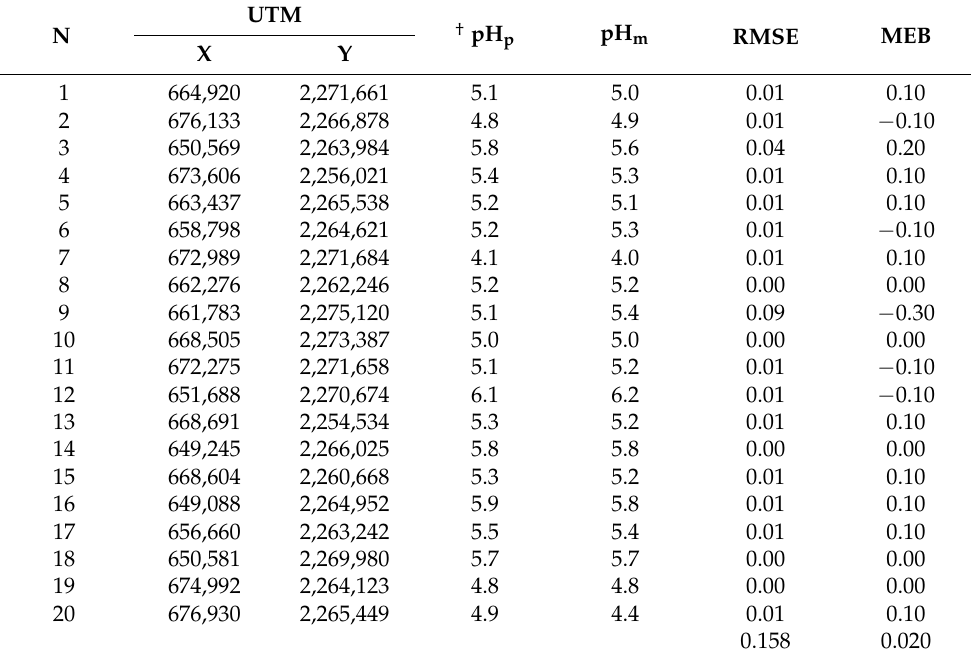
Table 4. Accuracy of the pH map of the municipality of Tlajomulco de Z ú ñiga,